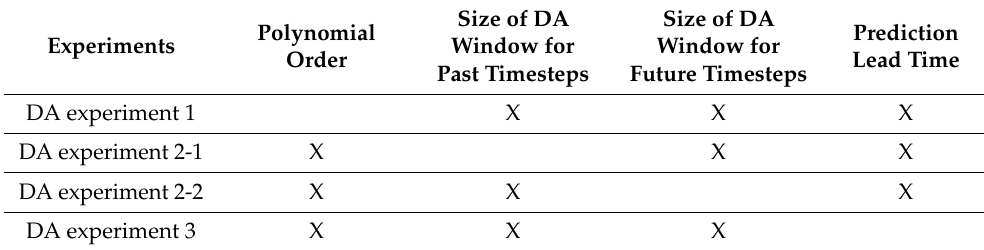
Table 1. Summarized configuration of the DA